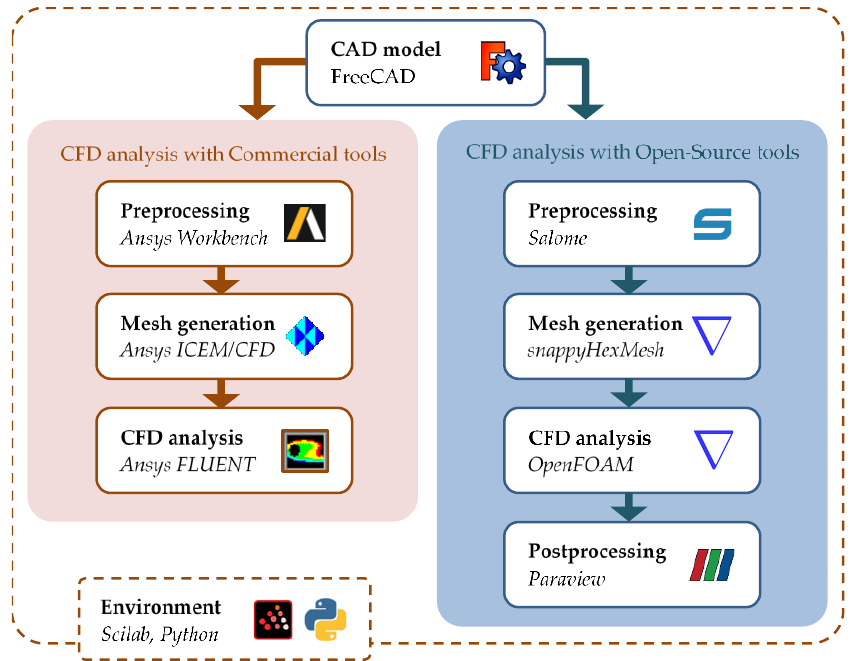
Figure 24. Software used to implement the two analysis modules.